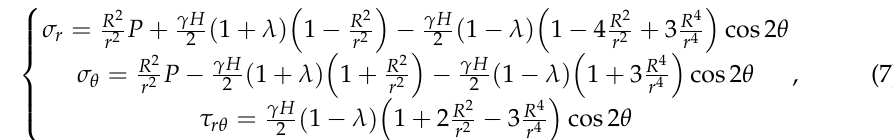
Figure 6. Pressure time history curve of different fracturing methods.